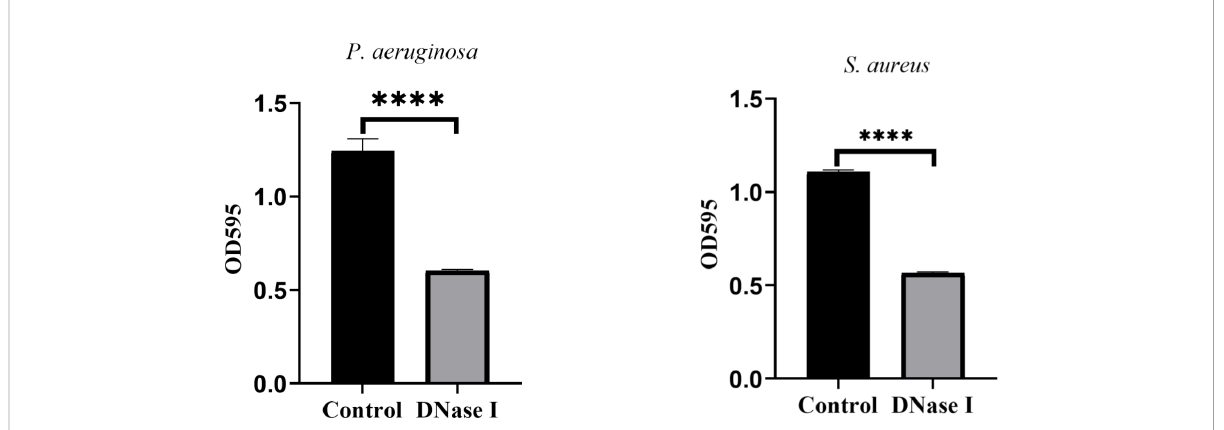
FIGURE 9 Results of the crystal violet staining of the indwelling catheters. OD values of crystal violet staining for indwelling catheters in two rabbit groups. The results are presented as mean ± SD. An asterisk indicates a signi fi cant difference; **** indicate p < 0.0001, compared with the values in the drug-free control group using t -tests (n =